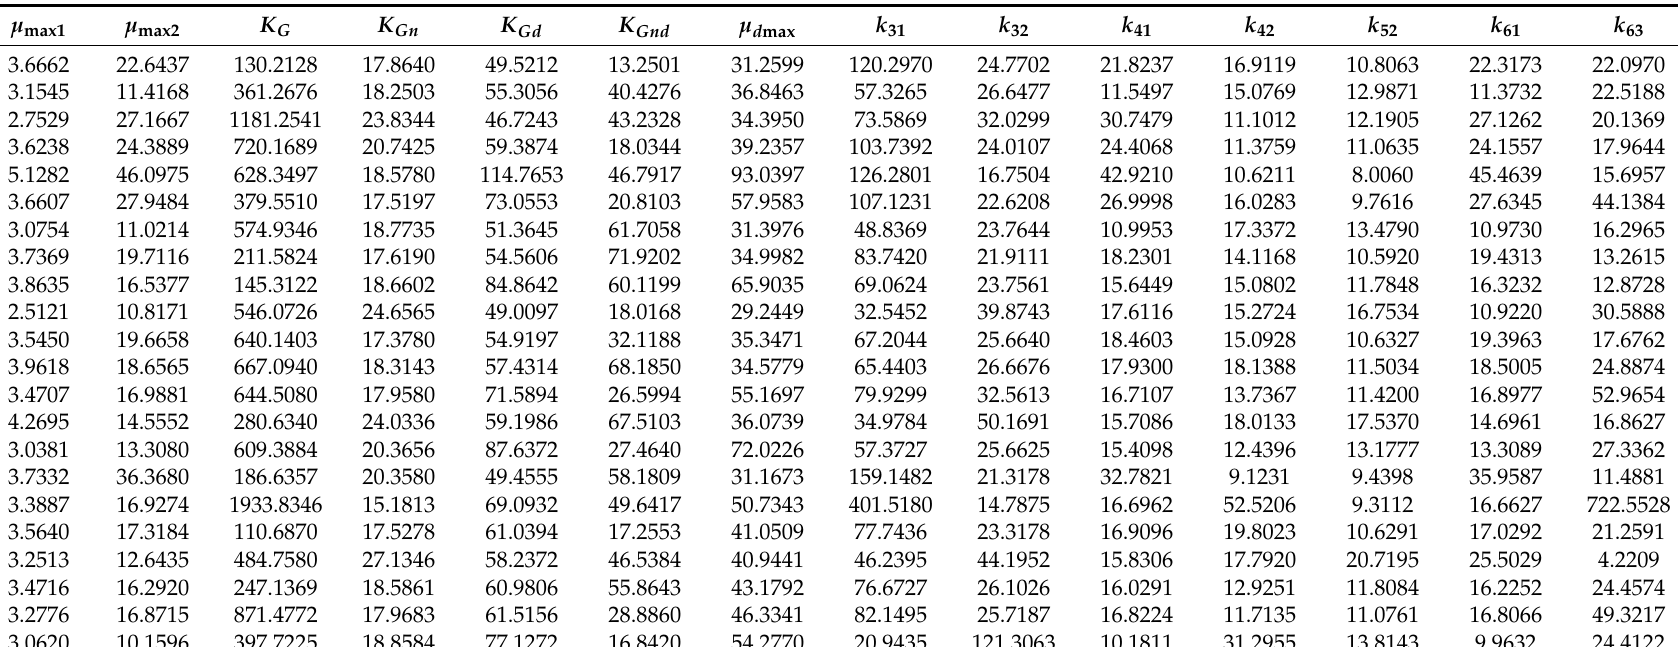
Table A2. Parameter estimation error relative standard deviations for the 22 selected